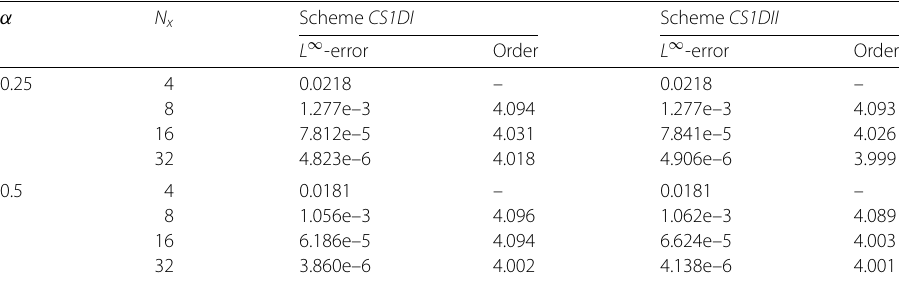
Table 3 Numerical comparison results of schemes CS1DI and CS1DII for Example 2, at T = 1 with N = 1000 and different N x and α